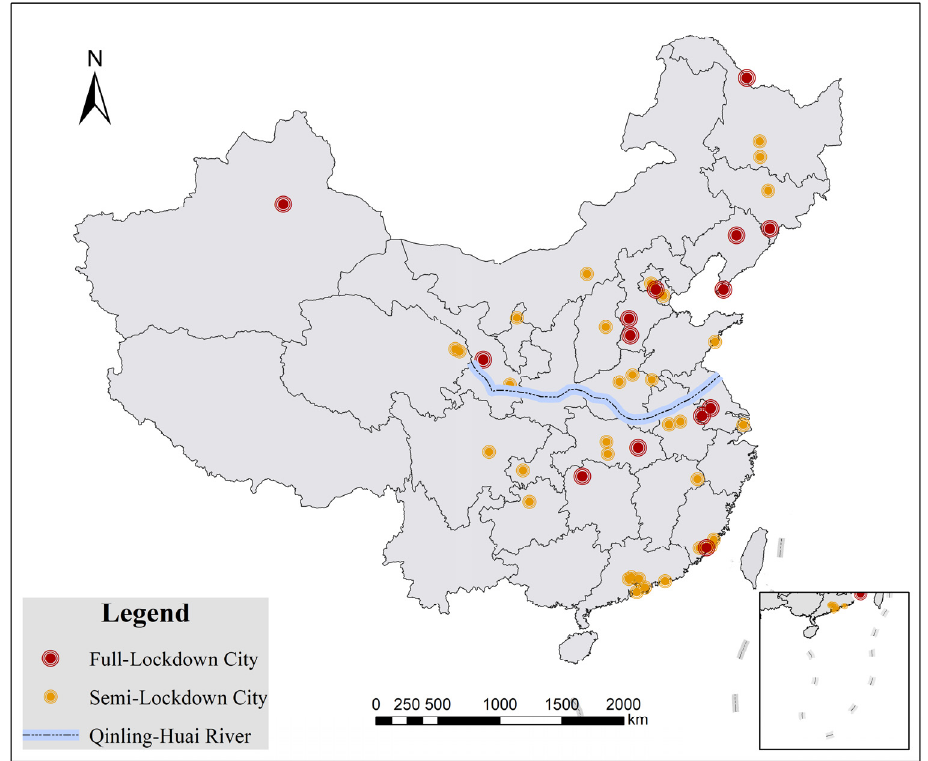
Figure 1. The locations and type of lockdown cases since January 2020 in China.